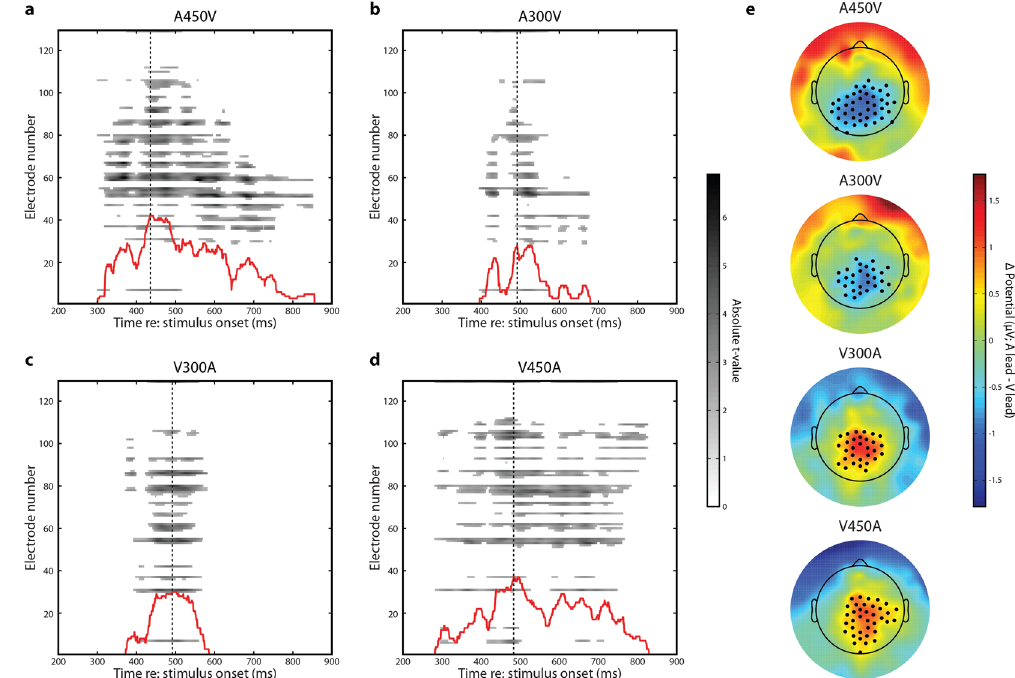
Figure 4. Spatiotemporal Clustering Results. ( a ) Raster plot representation of the spatiotemporal cluster in the A450V condition. The absolute value of the t-statistic is indicated for each time point for comparisons which are both individually significant (p < 0.05) and part of the significant spatiotemporal cluster. The inset red line indicates the number of significant electrodes at each time point (same scale as electrode number). The dashed line indicates the time point when the cluster reached maximum spatial size for the first time. ( b ) Raster plot representation of the A300V condition. Inset lines as in panel A. ( c ) Raster plot representation of the V300A condition. Inset lines as in panel A. ( d ) Raster plot representation of the V450A condition. Inset lines as in panel A. ( e ) Topographic representation of voltage differences between auditory and visual leading trials (A lead – V lead) for each SOA. Black dots indicate electrodes which are both individually significant (p < 0.05) and part of the significant spatiotemporal cluster. Time points for each SOA correspond with the dashed line in panels